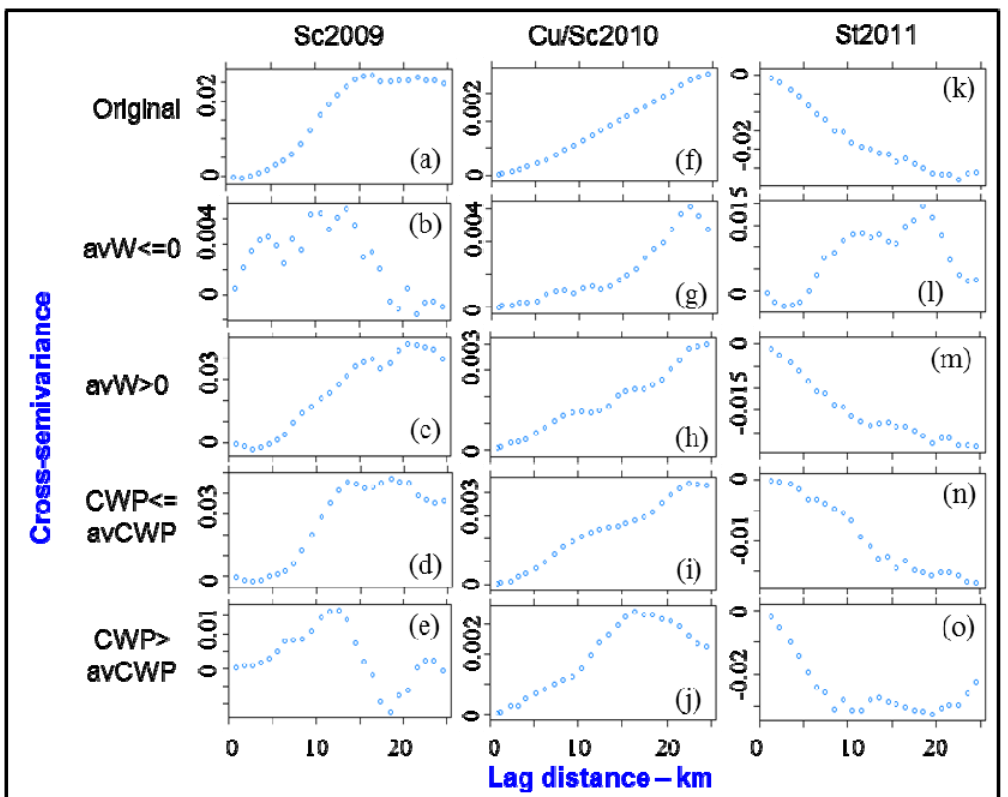
Figure 11. All aerosol model cross-variograms for three rain events indicating the spatial correlation of logarithm transformed rain rate with SO emissions for: ( a , f , k ) all grid 2 points; and grid data points stratified for: ( b , g , l ) column average vertical wind movement (avW) less than or equal to 0 ms-1; ( c , h , m ) avW >0 ms-1; ( d , i , n ) cloud water path (CWP) ≤ average CWP; and ( e , j , o ) CWP >average